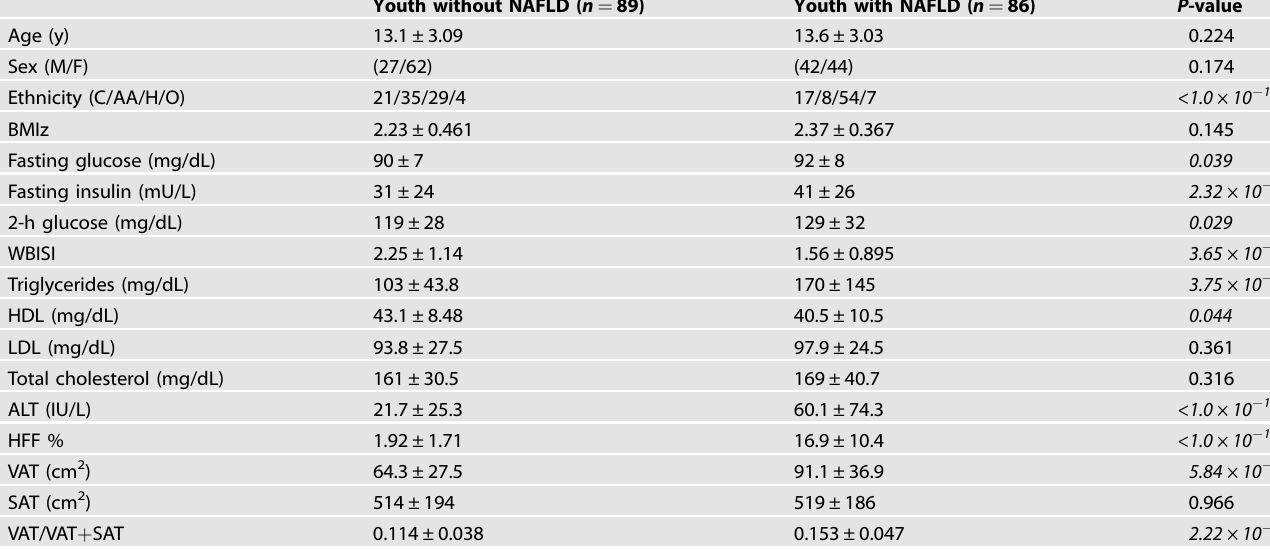
Table 1. The clinical characteristics of the cross-sectional cohort grouped by presence or absence of NAFLD are